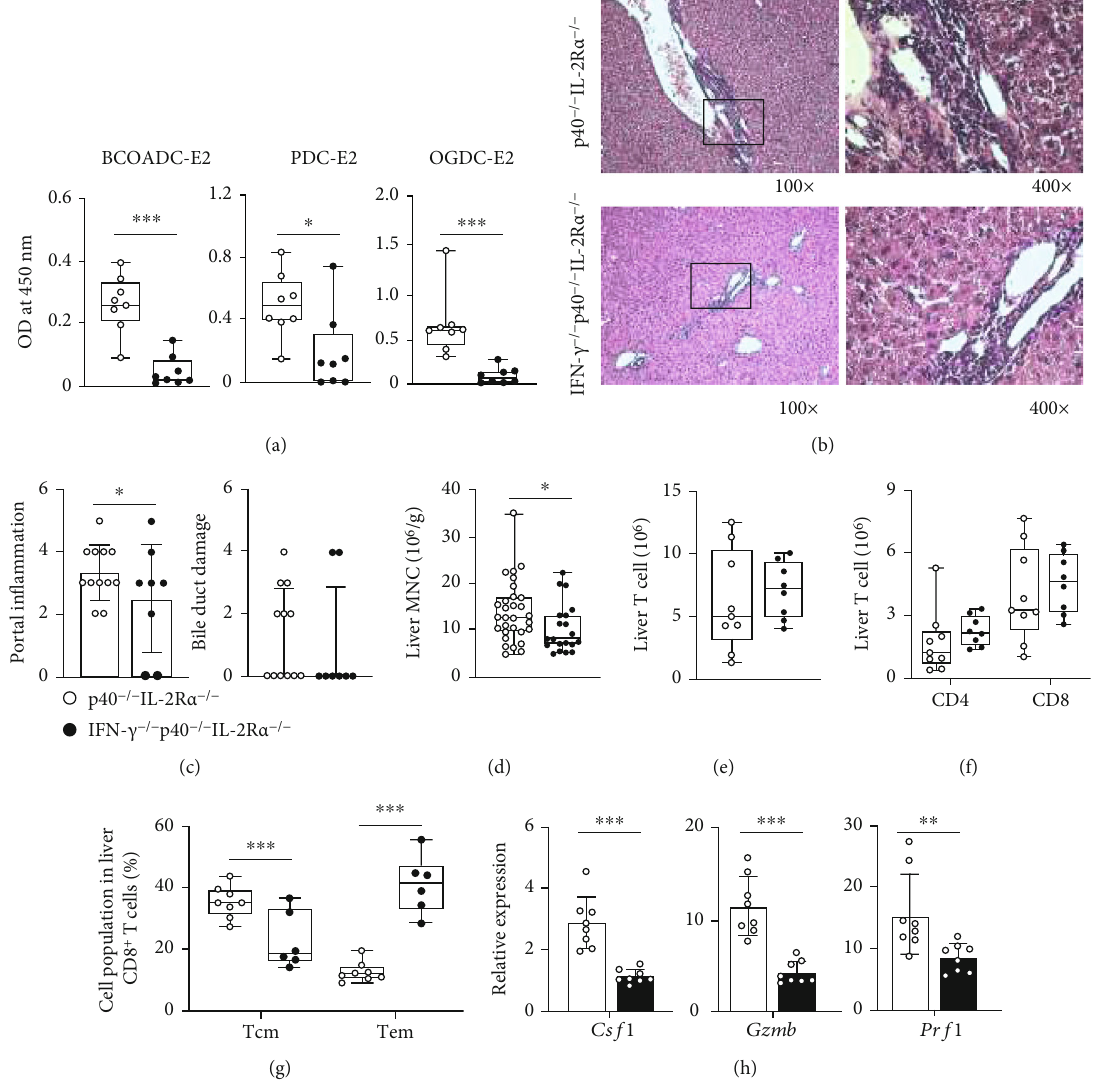
Figure 5: Autoimmune cholangitis in IFN- γ -/- p40 -/- IL-2Ra -/- mice. (a) Serum AMA levels in IFN- γ -/- p40 -/- IL-2Ra -/- ( n = 8 ) and p40 -/- IL- 2Ra -/- ( n = 8 ) mice. (b) Representative H&E of the liver at 100x and 400x magni fi cation. (c) Liver pathological score of IFN- γ -/- p40 -/- IL- 2Ra -/- ( n = 8 ) and p40 -/- IL-2Ra -/- ( n = 12 ) mice. (d) Densities of liver MNCs in IFN- γ -/- p40 -/- IL-2Ra -/- ( n = 20 ) and p40 -/- IL-2Ra -/- ( n = 30 ) mice. (e) Numbers of T cells in the liver from IFN- γ -/- p40 -/- IL-2Ra -/- ( n = 8 ) and p40 -/- IL-2Ra -/- ( n = 9 ) mice. (f) Numbers of CD4 + and CD8 + T cells in the liver from IFN- γ -/- p40 -/- IL-2Ra -/- ( n = 8 ) and p40 -/- IL-2Ra -/- ( n = 9 ) mice. (g) Percentages of CD8 + T central memory (Tcm) and e ff ector memory (Tem) cells from IFN- γ -/- p40 -/- IL-2Ra -/- ( n = 6 ) and p40 -/- IL-2Ra -/- ( n = 8 ) mice. (h) Quantitative real-time PCR analysis for mRNA levels of Csf1 , Gzmb , and Prf1 in IFN- γ -/- p40 -/- IL-2Ra -/- ( n = 8 ) and p40 -/- IL-2Ra -/- ( n = 8 ) mice. ∗ p < 0 : 05, ∗∗ p < 0 : 01, and ∗∗∗ p < 0 : 001